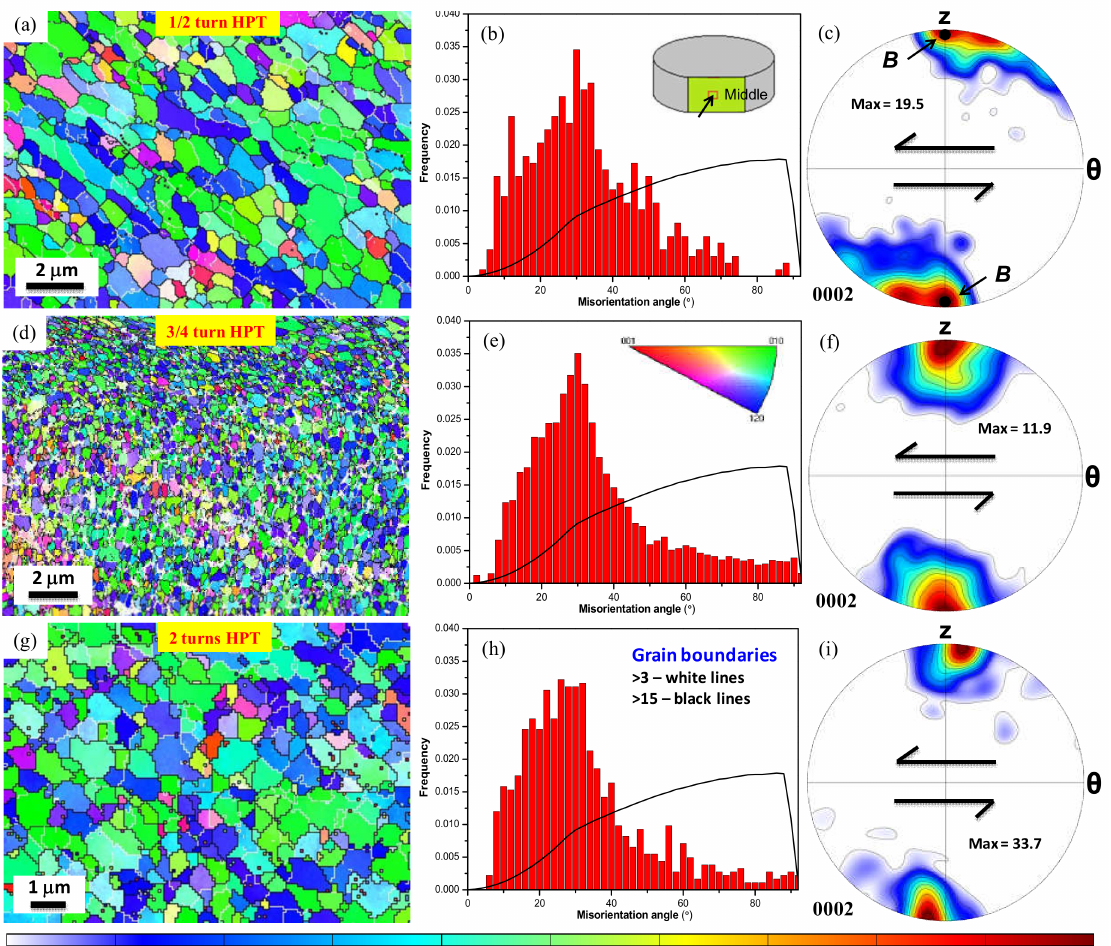
Figure 5. Electron backscatter diffraction (EBSD) orientation images accompanied with grain boundary misorientations and associated microtexture in (0002) pole figure for the 1/2 turn ( a – c ), 3/4 turn ( d – f ), and 2 turns ( g – i ) micro-HPT products acquired at the outer edge and middle-section of the HPT-disk (see the inset of Figure 5b). The Mackenzie distribution of misorientation angles (uncorrelated) is plotted by solid black line. Note the differences in scale